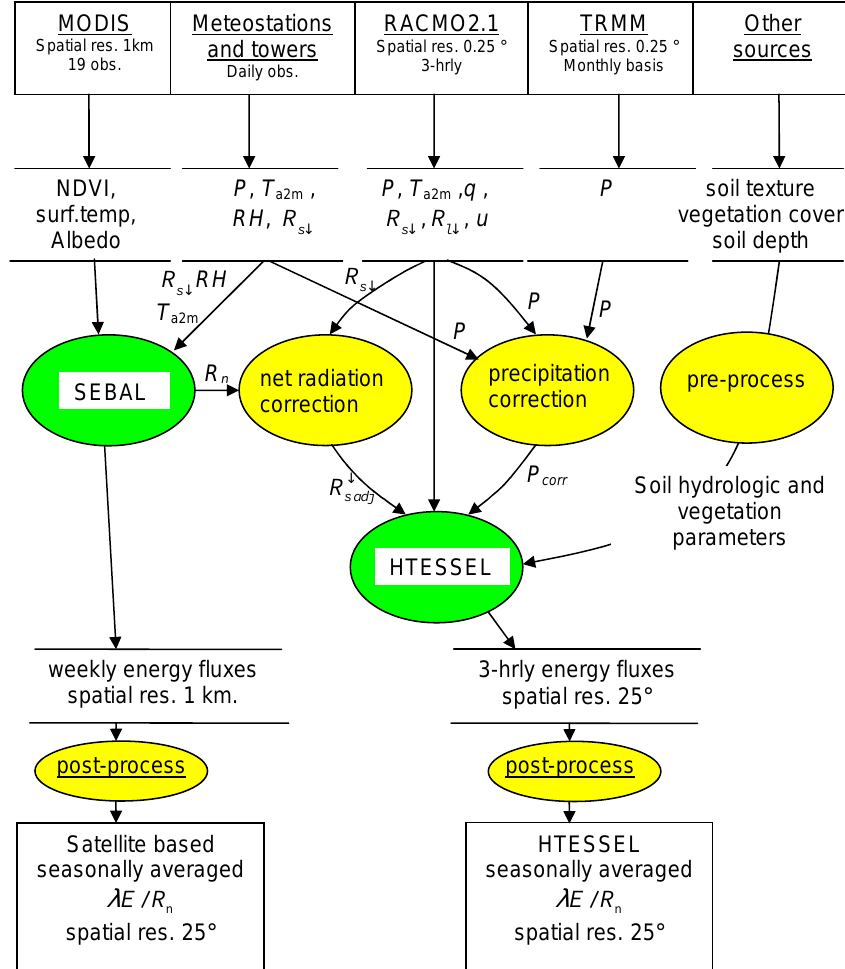
Fig. 9. Flow diagram of the in- and output of SEBAL and